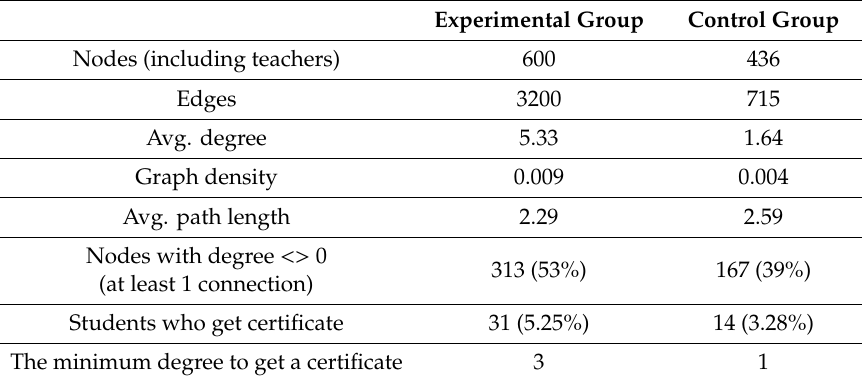
Table 2. Comparison of network metrics for the different instances of an online course.